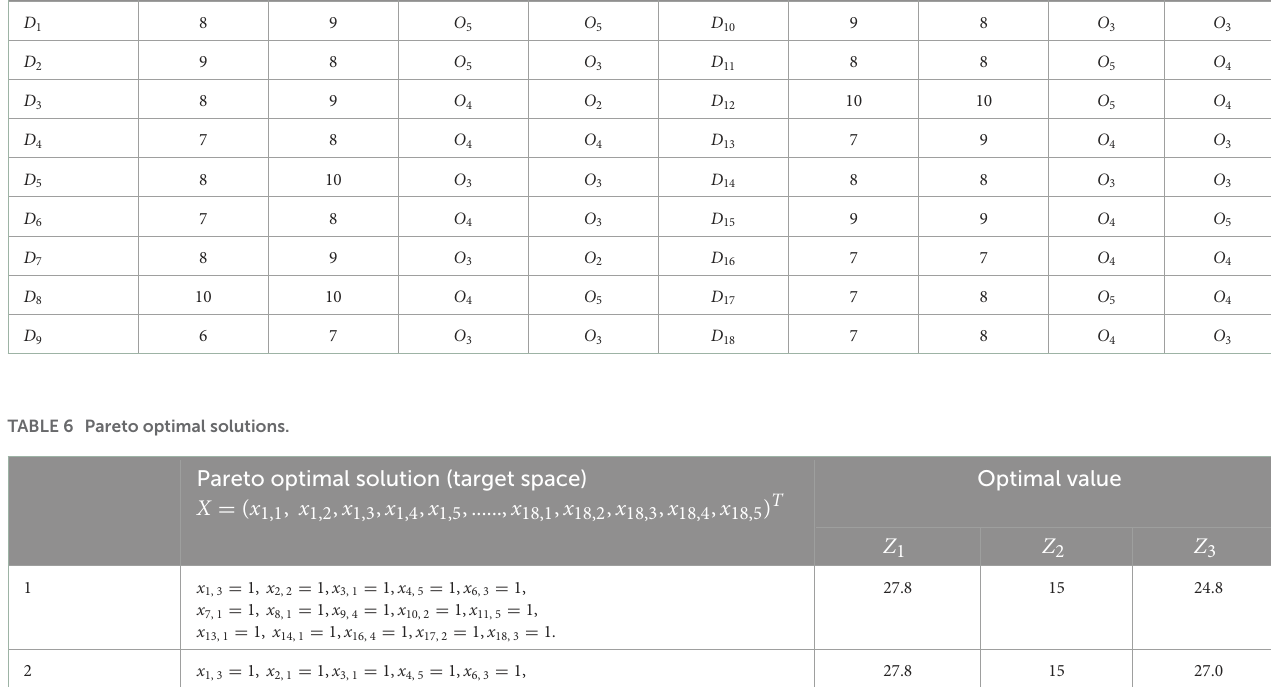
TABLE 5 Hospital evaluation level of patients. Patients